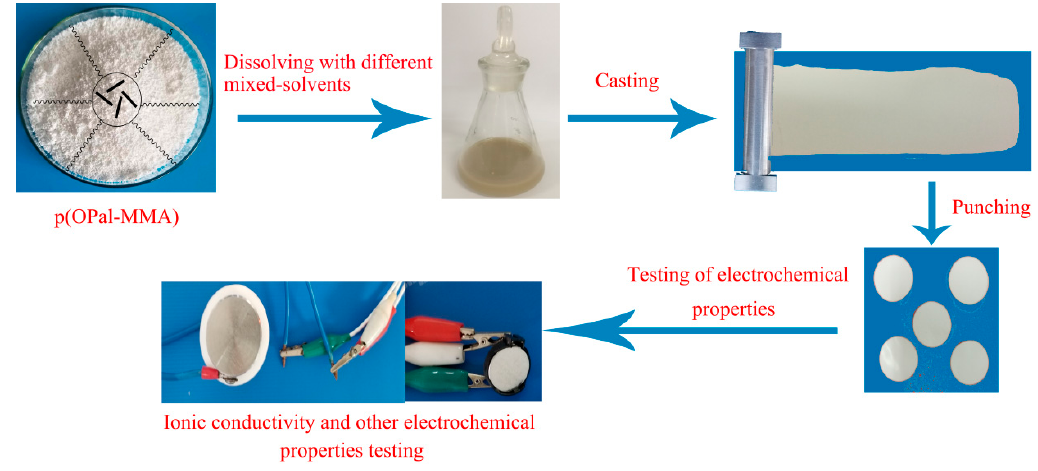
Figure 1. The preparation of p(OPal-MMA) polymer membrane.